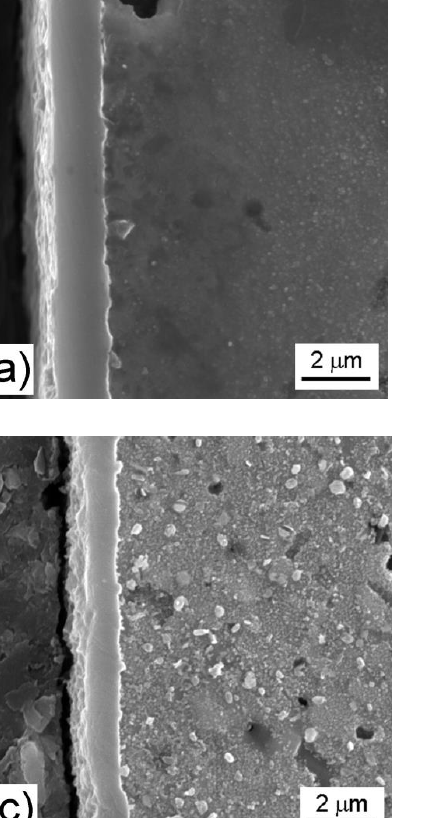
Table 3. Chemical composition of the oxide layers after 300 h of oxidation at 800 °C (in wt %, EDS).